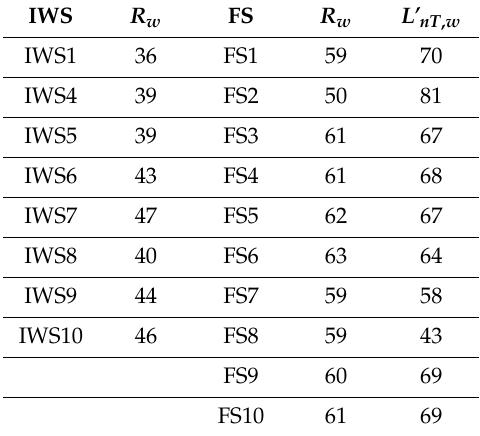
Table 16. Sound reduction indexes ( R w ) and sound pressure level of weighted standard impact of floor systems and internal wall systems